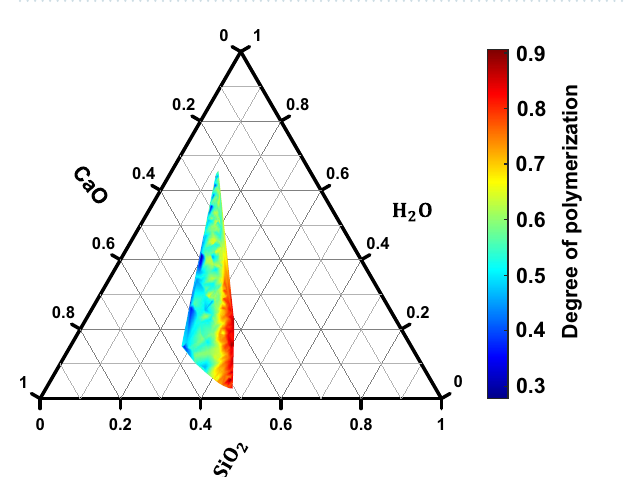
Figure 2. Ternary diagram showing the stiffness moduli ( a ) C 11 , ( b ) C 22 , ( c ) C 33 , ( d ) C 44 , ( e ) C 55 , ( f ) C 66 , ( g ) C 12 , ( h ) C 13 , and ( i ) C 23 values obtained via MD simulations with varying CaO–SiO 2 –H 2 O molar fractions.